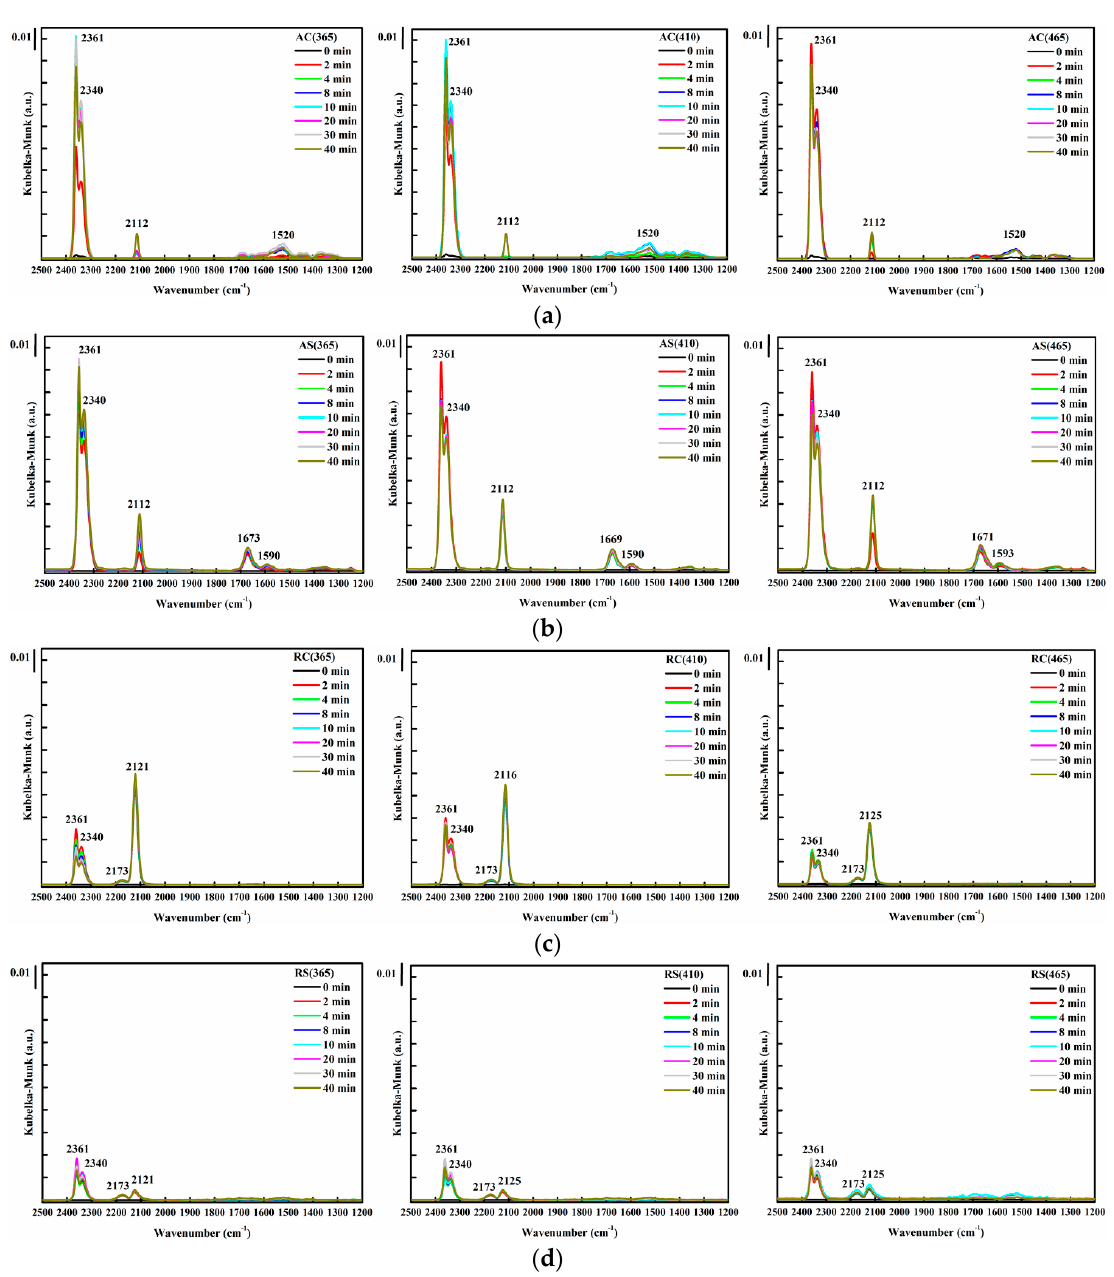
Figure 8. DRIFTS spectra of CO oxidation using Au catalyst on various supports: ( a ) anatase cubic TiO 2 ; ( b ) anatase spheroidal TiO 2 ; ( c ) rutile cubic TiO 2 ; and ( d ) rutile spheroidal TiO 2 , photo-deposited at different wavelengths (from left to right, 365, 410 and 465 nm).